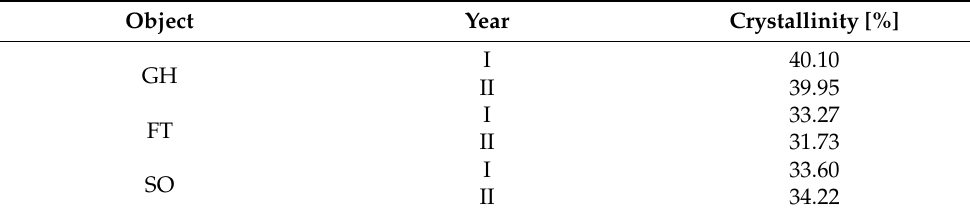
Figure 2. ( a ) XRD patterns for the starches analyzed in the paper. The intensity of the diffraction curves is relative, just to compare the pattern between the samples. ( b ) Crystalline part of the GH II starch diffraction pattern. The intensity is relative. (GH—greenhouse, FT—foil tunnel and SO—soil). Table 6. Crystallinity of the samples, as calculated from powder diffraction patterns.